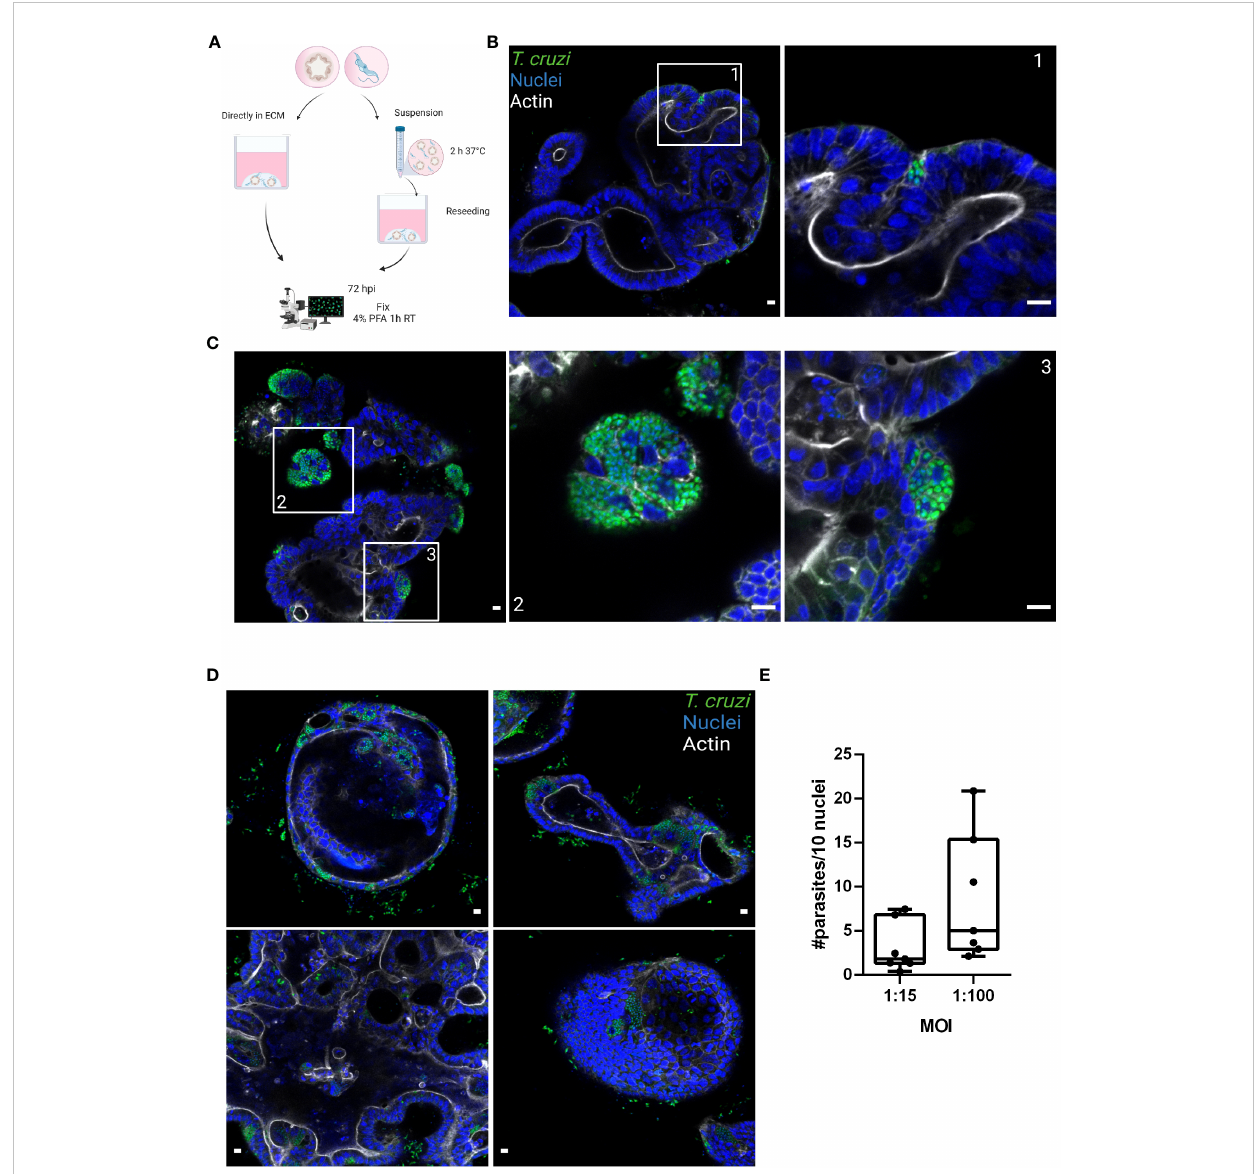
FIGURE 2 Basolateral infection of organoids by T. cruzi . (A) Schematic representation of the infection protocol. Murine colon-organoids were removed from the matrix and either directly re-plated with the parasites or incubated for 2 h in suspension at 37°C before being re-plated. At 72 h post-infection parasite load was assessed by confocal microscopy. Created with BioRender.com (agreement number RW2506JDYE) (B) Representative image of organoids infected with parasites (MOI 1:15) included directly in the matrix. (C) Representative image of organoids infected with parasites in the absence of matrix. (D) Organoids infected with a MOI of 1:100 show discrete parasite nests. (E) Number of intracellular parasites every 10 cells over a 72 h period of infection. Data from one representative experiment out of 2 independent experiments (different organoid lines per experiment). Data are expressed as median and interquartile range and compared using Mann-Whitney test (n = 7). Scale bar: 10 µm. Nuclei (blue): methyl green staining, T. cruzi (green): anti-trypanothione reductase immune-staining, and Actin (white): phalloidin Texas Red